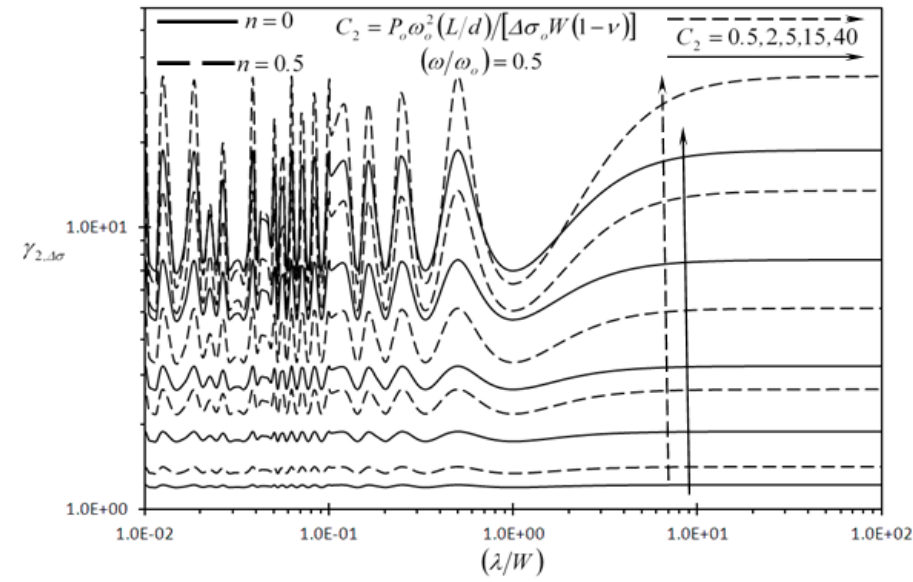
ω 2 ( L / d )/[ ∆ σ W (1 − v )]} on o o o 2, ∆ σ